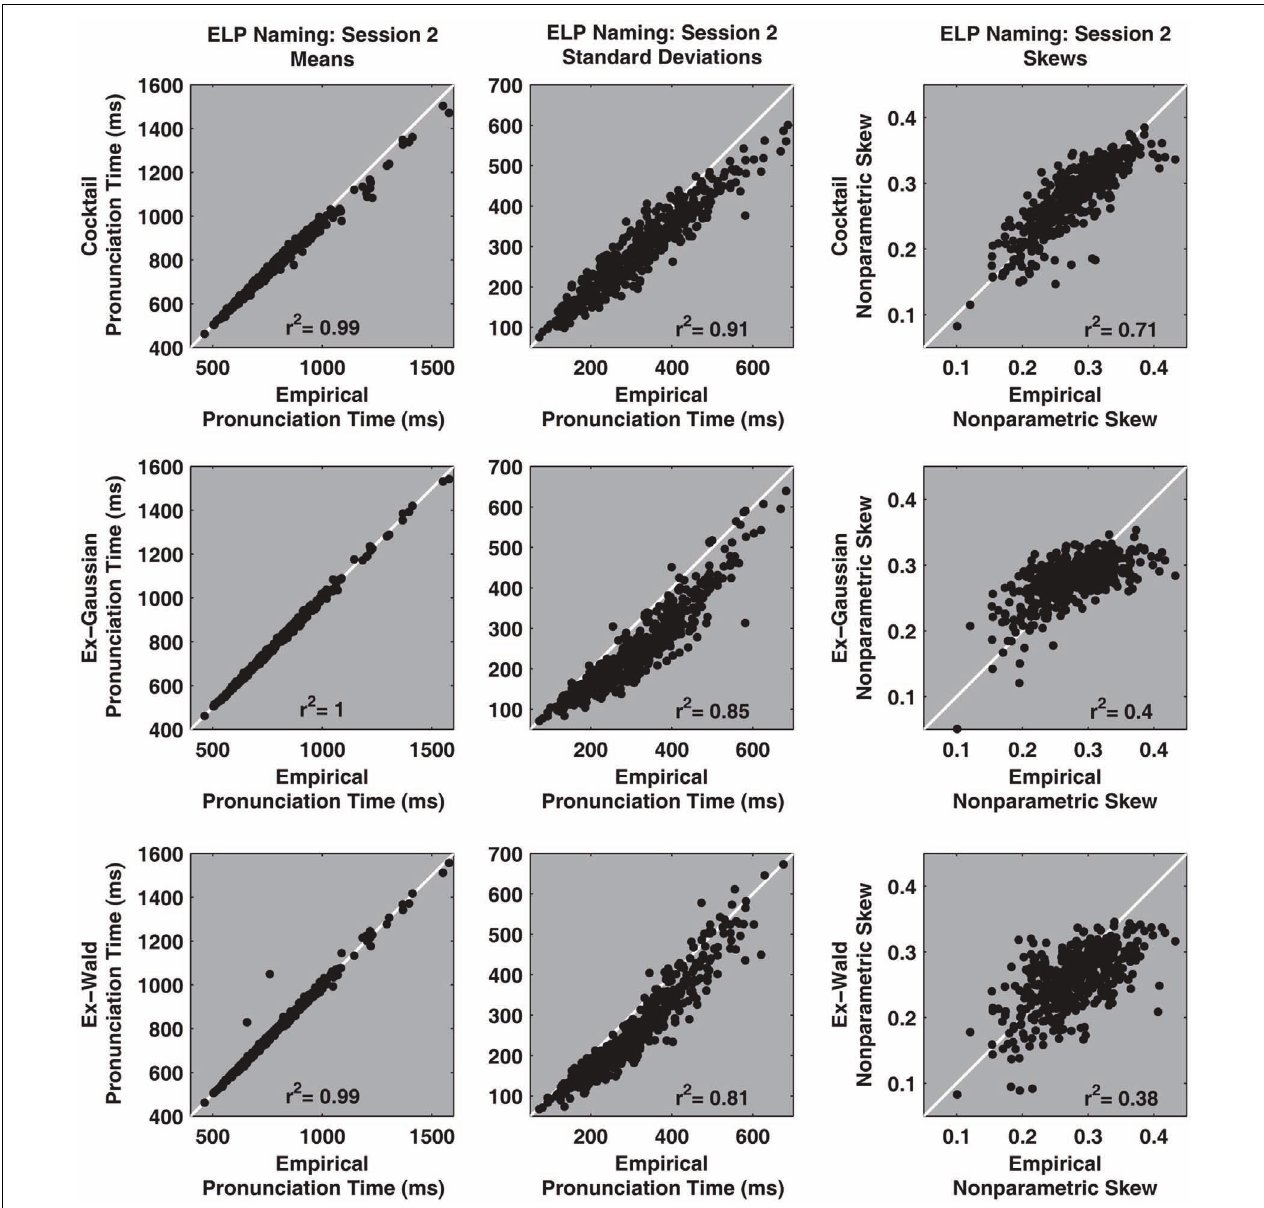
third rows depict the same contrasts for the ex-Gaussian and e-Wald distributions, respectively. Overall, the cocktail description recovers descriptive parameters better than the exponential alternatives.The estimates were computed for all participants, regardless of whether the fits were reliable or